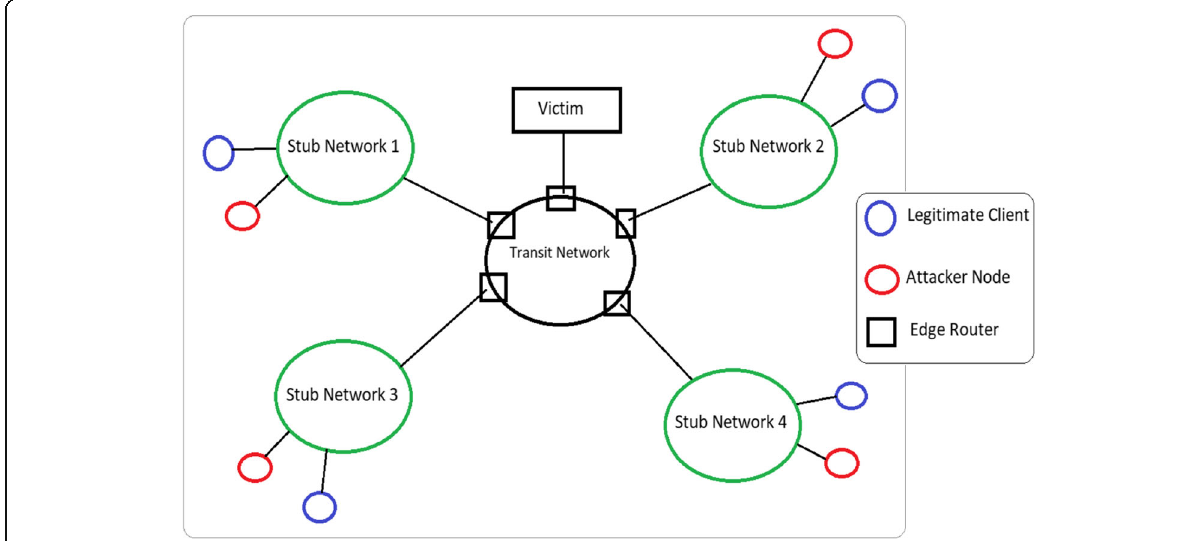
Fig. 2 Overview of the topology in transit network for connecting two or more stub networks. Transit network is nothing but a regional Internet service provider (ISP) or backbone